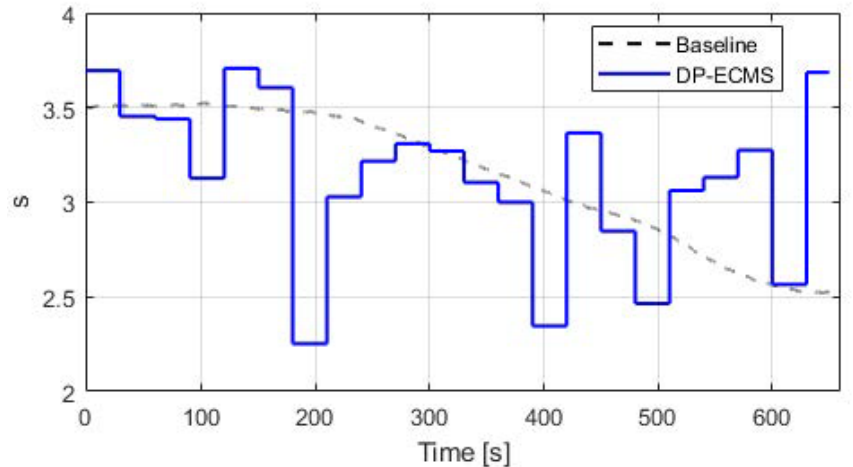
Figure 12. EF comparison for DP-ECMS and baseline.